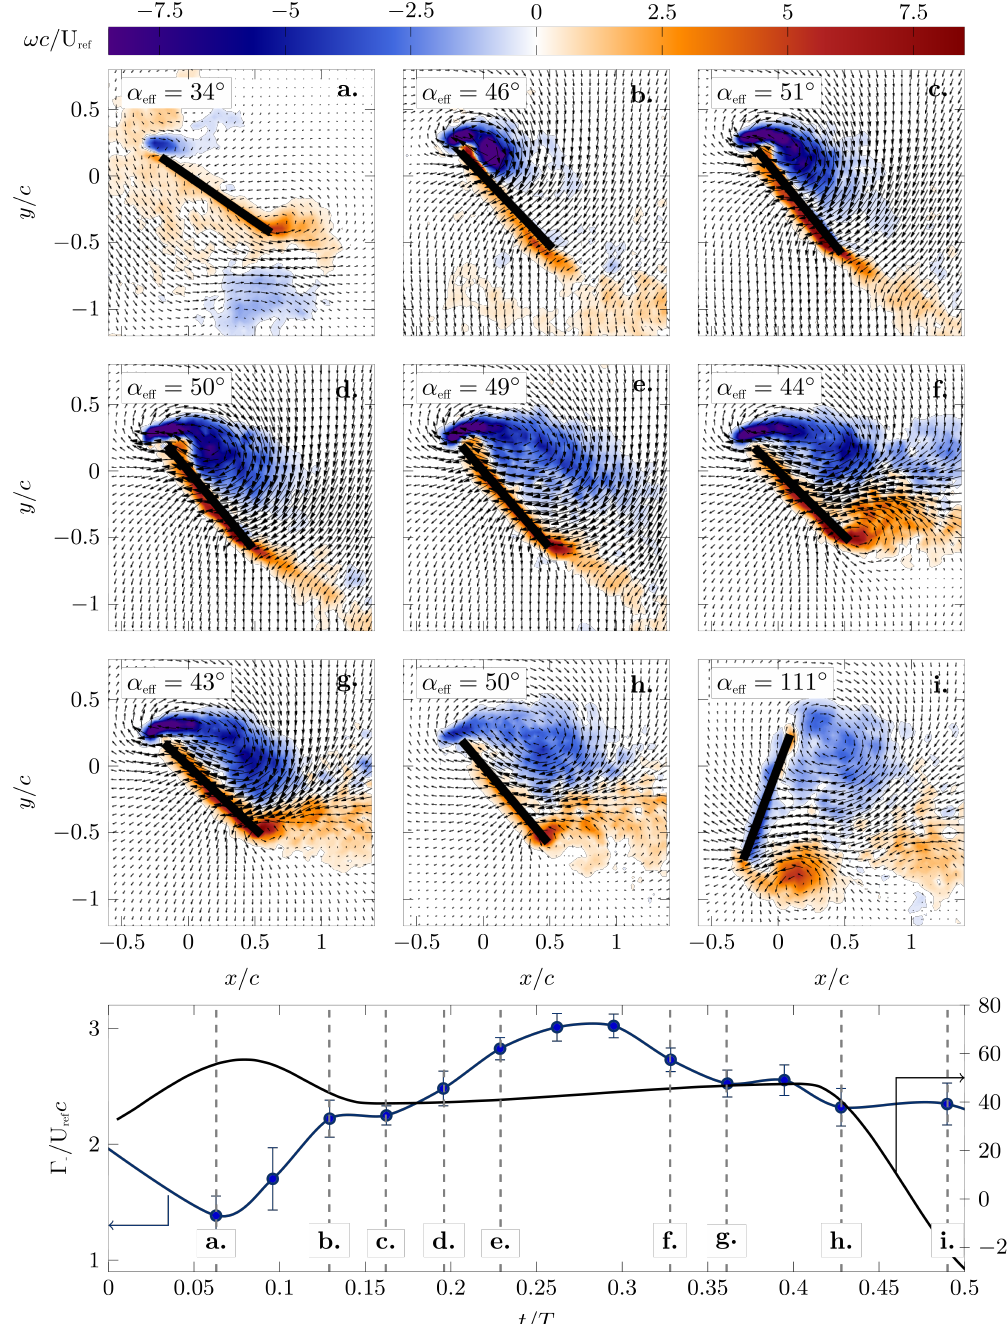
Figure 10. Velocity and vorticity fields at selected phases within the flapping cycle for the final generation of the maximum lift optimization of the pitch